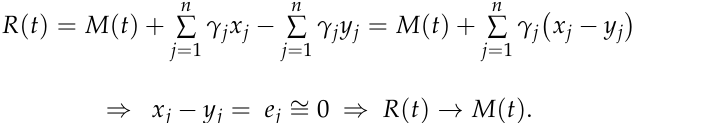
Figure 9. Message 1, masked and retrieved, and the error between these two signals.